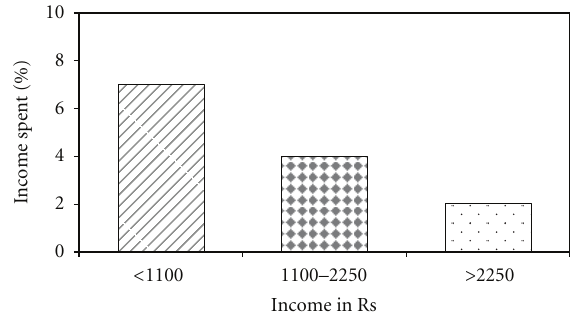
Figure 1: Proportion of income spent for diagnosis and treatment by di ff erent income